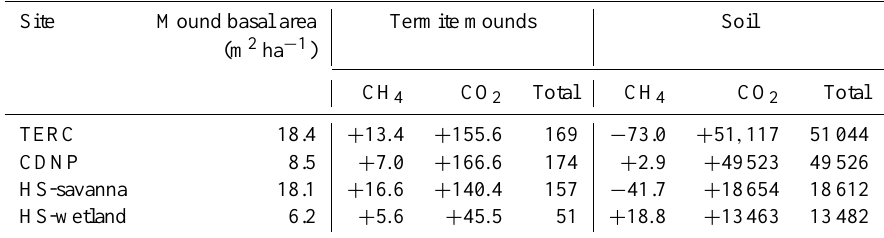
Table 6. Annual mean fluxes of CH 4 and CO 2 in kg CO 2 -eha − 1 yr − 1 from termite mounds and soil at each of the four sites. Site Mound basal area Termite mounds